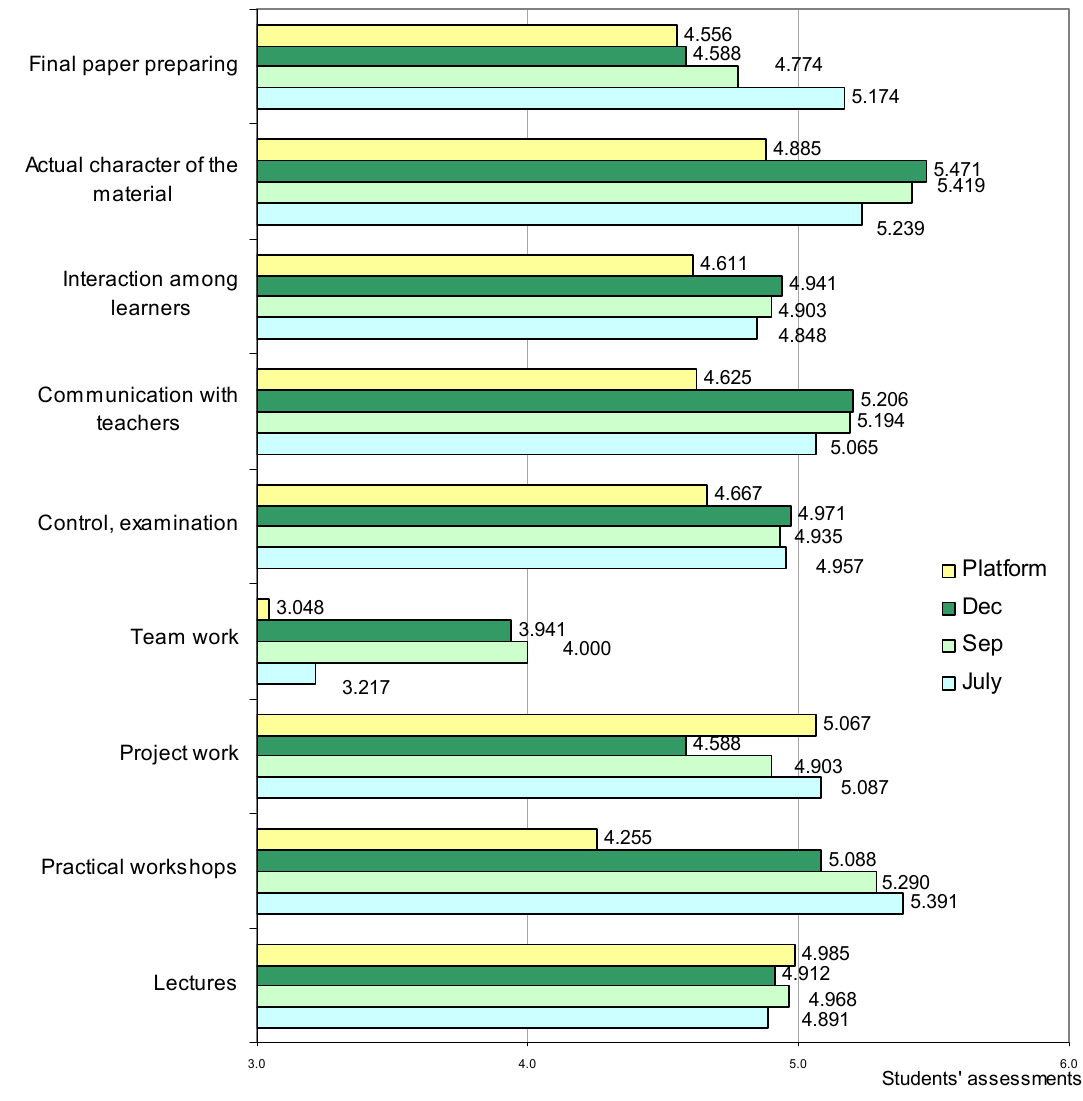
Figure 1. Summary of learning organization assessment results.